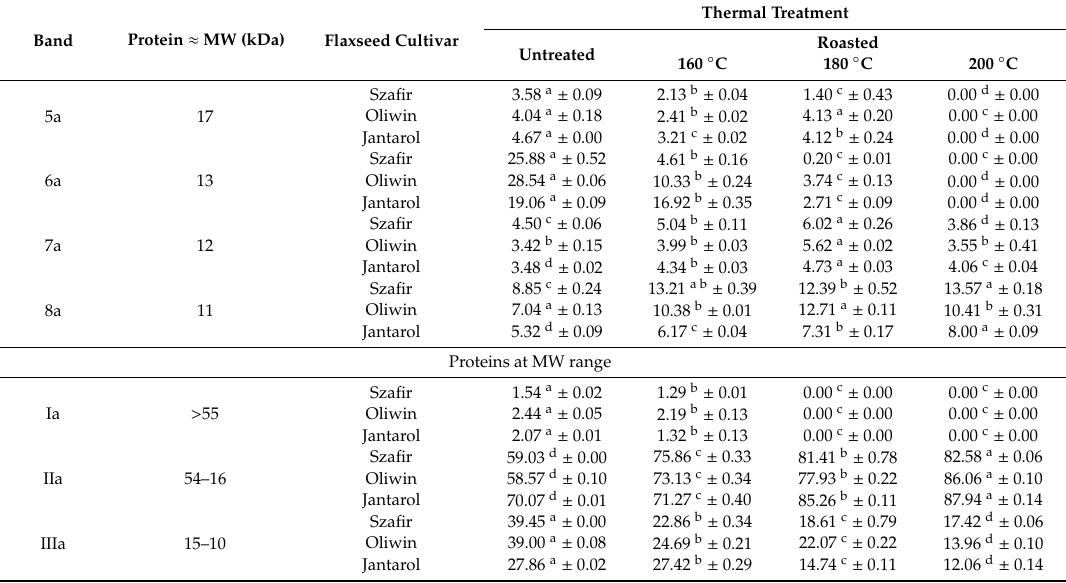
Protein contribution (%)—the percentage share of protein in the total protein content. MW—protein molecular weight. The means ± SD marked with di ff erent superscript letters in a row are significantly di ff erent (one-way ANOVA, p < 0.05, and post hoc Tukey’s test). Table 2. The e ff ect of flaxseed roasting on changes in the protein profile of defatted meals—the SDS-PAGE under reducing